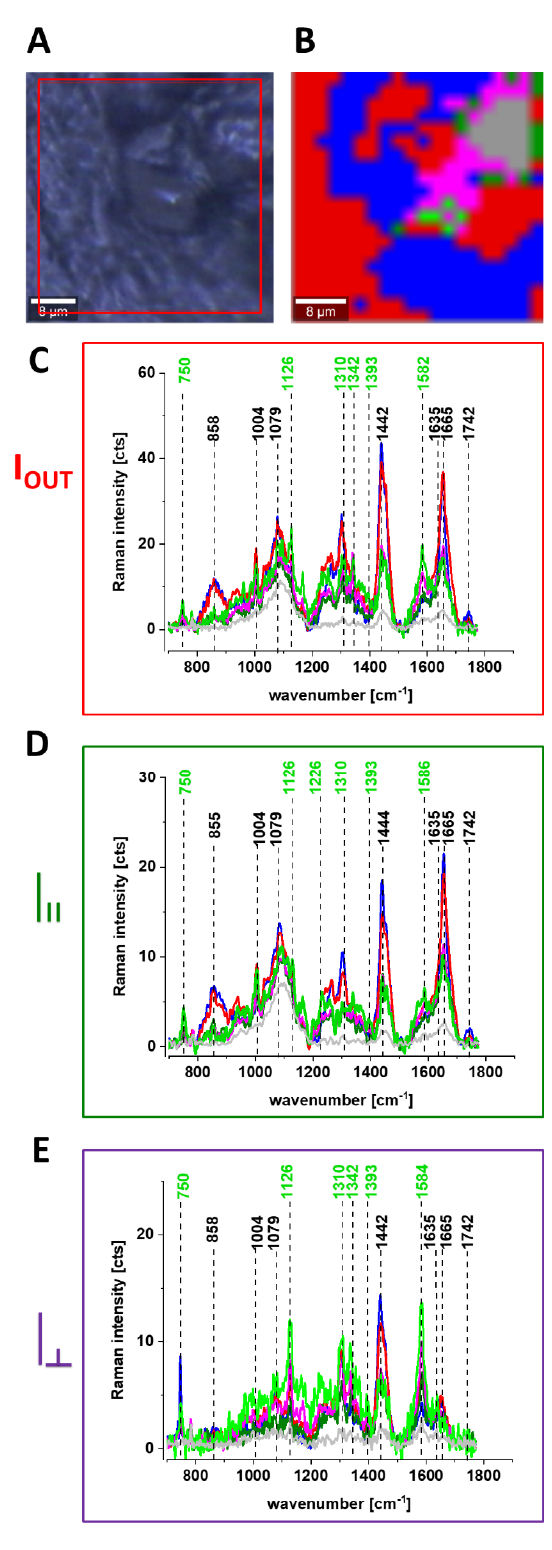
Figure 6. Microscopy image ( A ), Raman image (40 × 40 µ m, resolution 0.5 µ m, integration time 1.0 s) ( B ), the average Raman spectra of lipids blue, proteins red, cytochrome green, mitochondrion magenta at 532 nm at different experimental geometries for Raman scattering: without polarization analyzer ( C ), at parallel ( D ) and perpendicular ( E ) polarizations of the incident and Raman scattered beams for P 129 Infiltrating ductal carcinoma